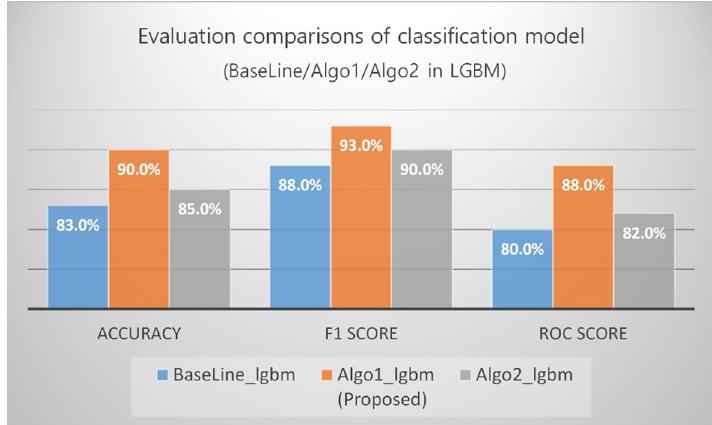
Fig. 14 Evaluation comparisons of classification models—Baseline/Algo1/Algo2 in LGBM